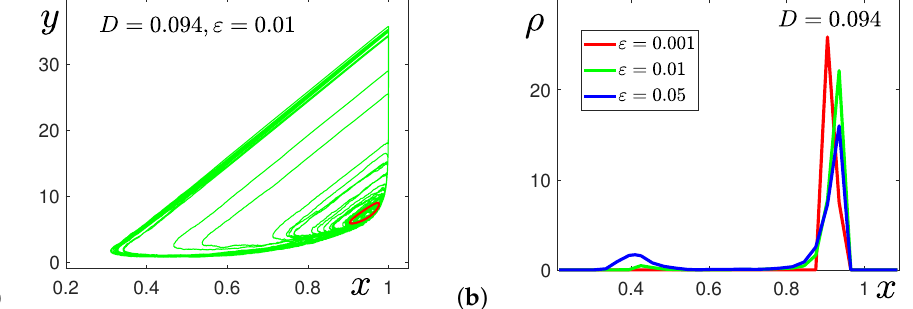
Figure 7. Noise-induced excitement in system (2) with D = 0.094: ( a ) phase trajectories of the deterministic (red) and stochastic (green) system; ( b ) probability density function ρ ( x ) for different values of noise